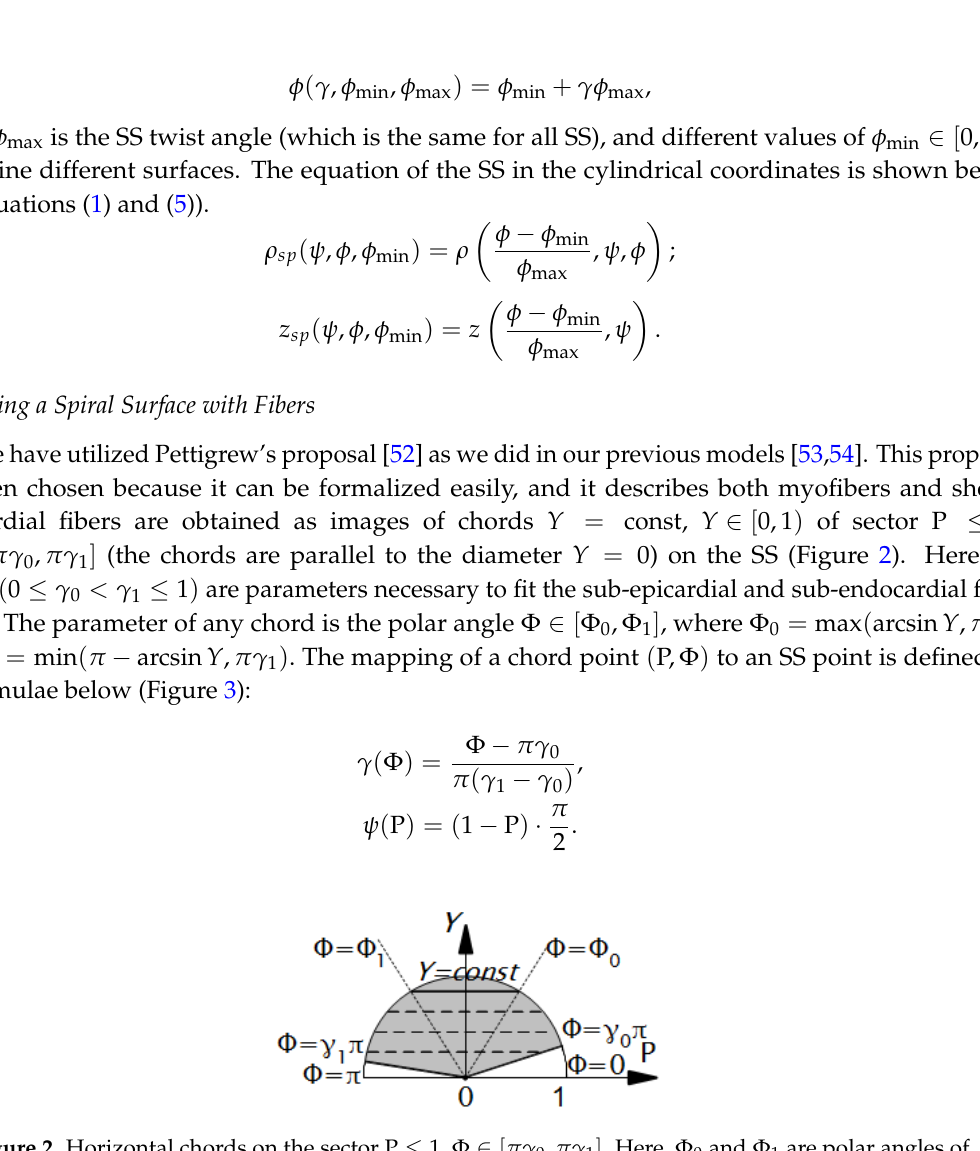
Figure 2. Horizontal chords on the sector P ≤ 1, Φ ∈ [ πγ 0 , πγ 1 ] . Here, Φ 0 and Φ 1 are polar angles of the right and left chord ends, respectively. Parameter γ 0 = 0.1, and γ 1 = 0.95.